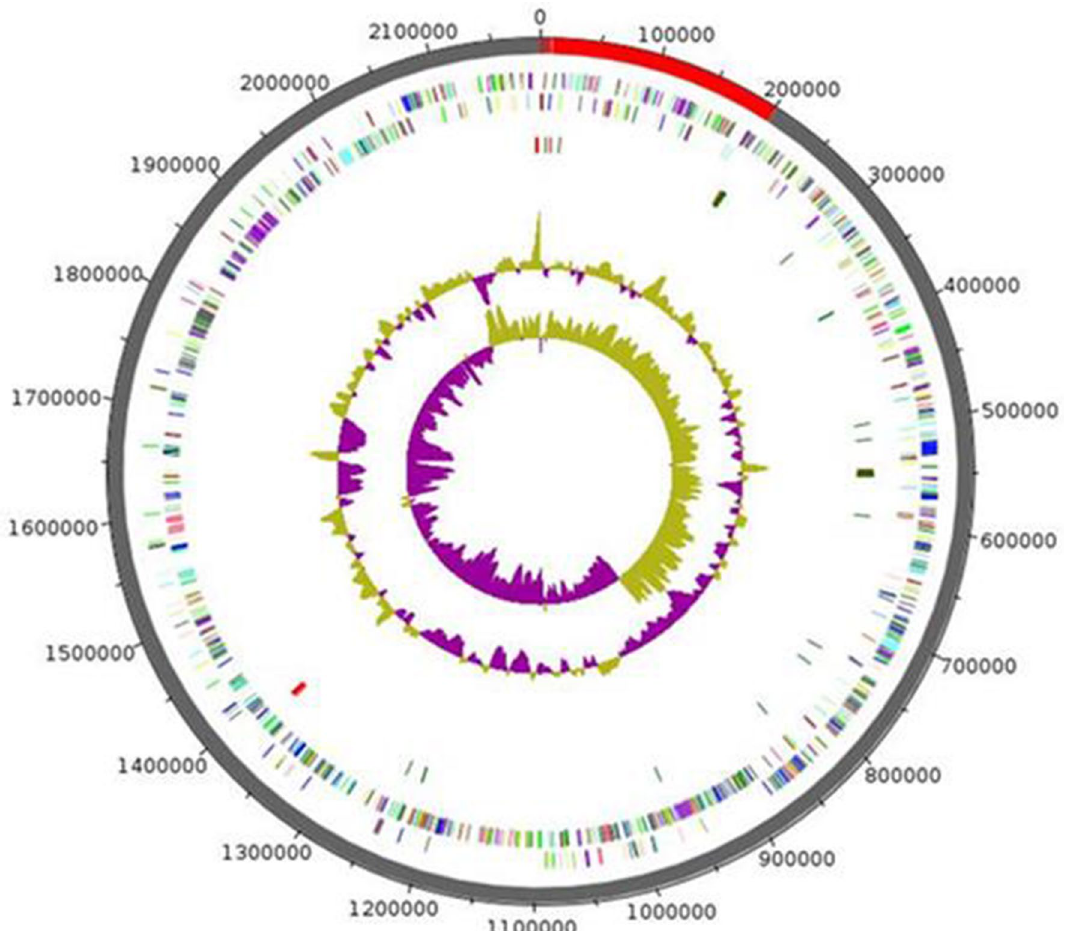
Figure 4. Graphical circular map of the chromosome of Anaerococcus urinimassiliensis sp.nov. From outside to the center: genes on the forward strand colored by COG categories (only genes assigned to COG), genes on the reverse strand colored by COG categories (only gene assigned to COG), RNA genes (tRNAs green, rRNAs red), GC content and GC skew.